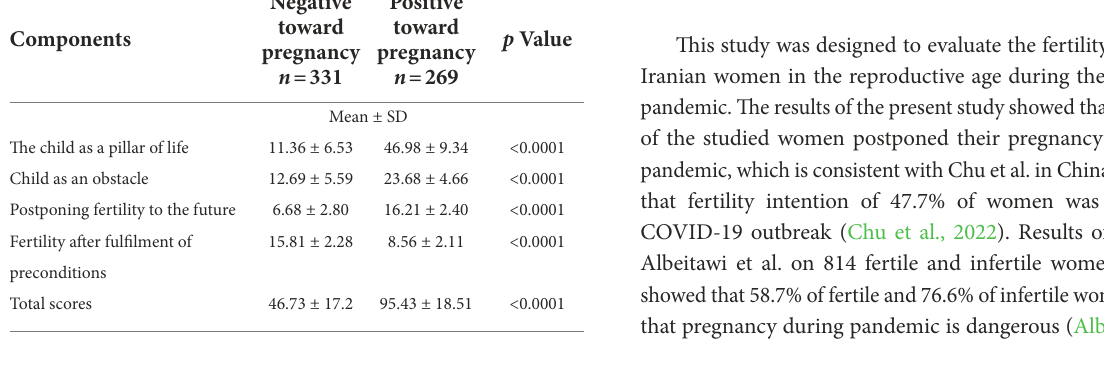
TABLE 3 Reasons for lack of interest in pregnancy during the COVID-19 pandemic among two groups with negative and positive attitudes toward